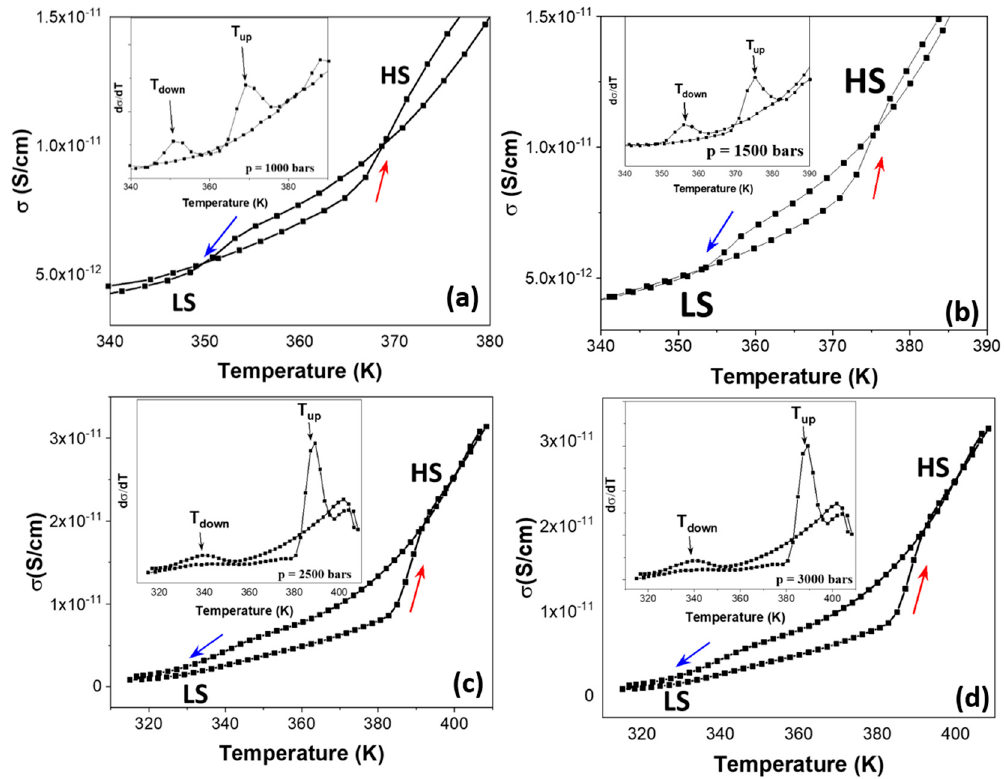
Figure 4. Temperature dependence of the AC electrical conductivity recorded on sample S2 under various external pressures: ( a ) 1000 bar; ( b ) 1500 bar; ( c ) 2500 bar; and ( d ) 3000 bar. The insets show the first derivative d σ /dT vs. T .